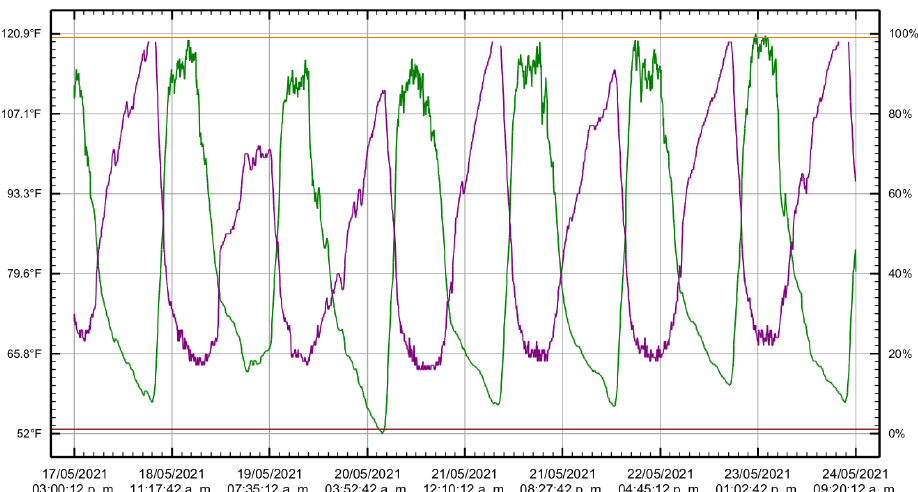
Figure 6. Temperature and humidity changes from 17 May to 24 May 2021. The green line represents the temperature, the purple line is the humidity, the horizontal line in mustard color on top is the high alarm, and the horizontal line in brown color at the bottom represents a low